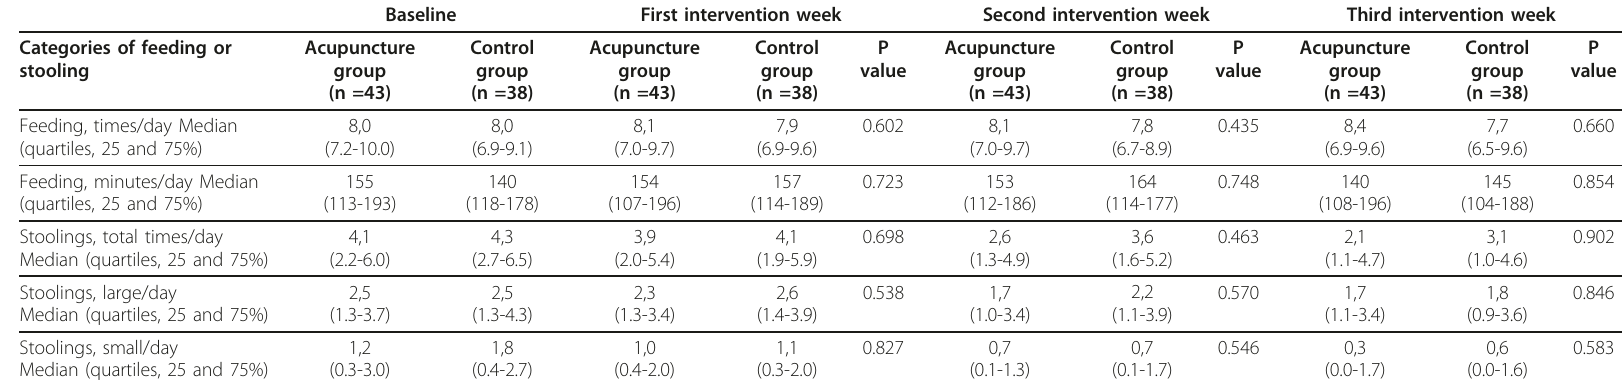
Table 2 Stooling and feeding during the baseline week and the three intervention weeks (Mann-Whitney U test was used.) Baseline First intervention week Second intervention